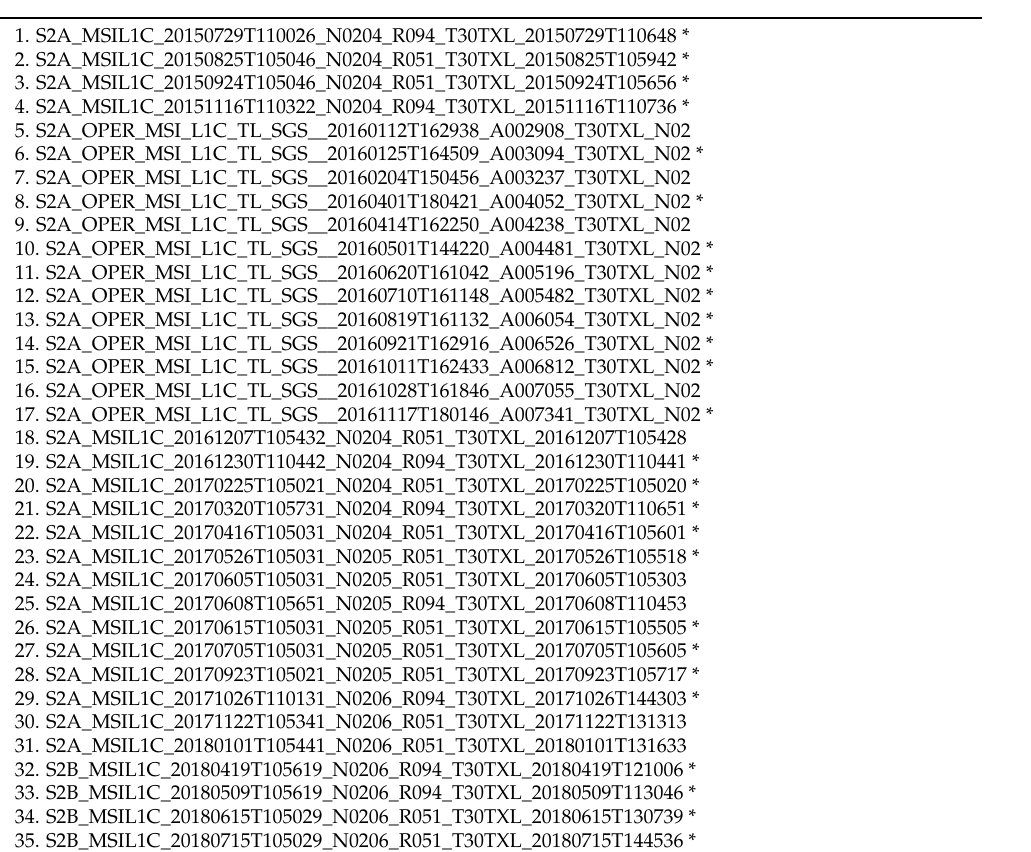
Table A1. List of Universal Resource Identifiers of images freely downloaded from the cloud. * Files processed for the NDI45 vegetation